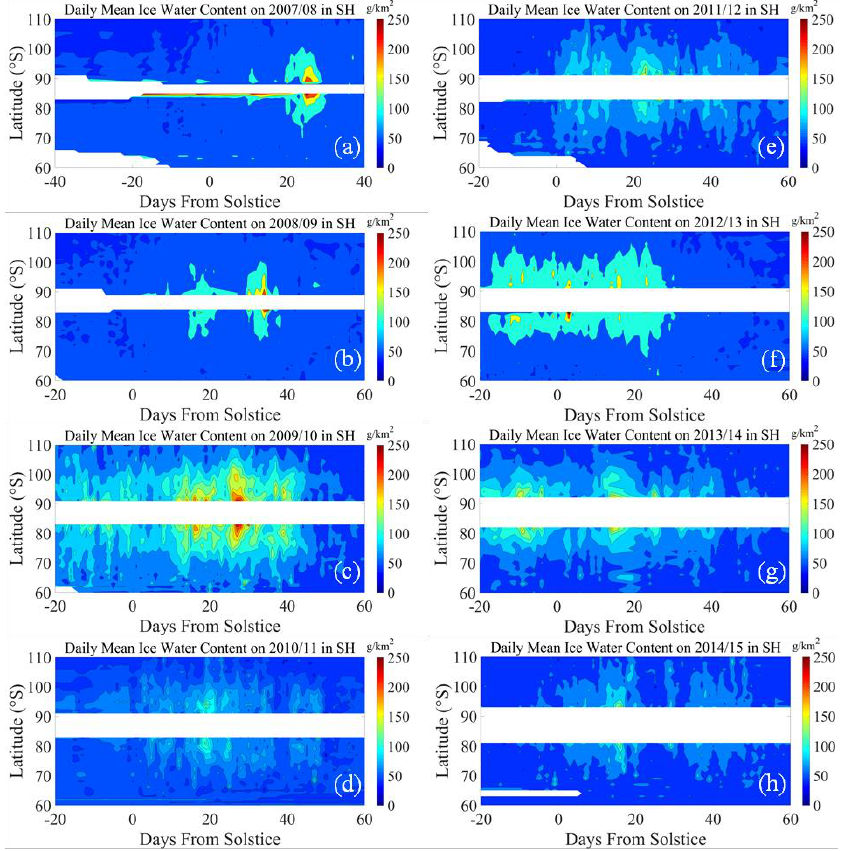
Figure 5. The distribution of daily averaged IWC during the PMC seasons from 2007/2008 to 2014/2015 in SH. (a) IWC on 2007/2008 PMC season; (b) IWC on 2008/2009 PMC season; (c) IWC on 2009/2010 PMC season; (d) IWC on 2010/2011 PMC season; (e) IWC on 2011/2012 PMC season; (f) IWC on 2012/2013 PMC season; (g) IWC on 2013/2014 PMC season; (h) IWC on 2014/2015 PMC season.